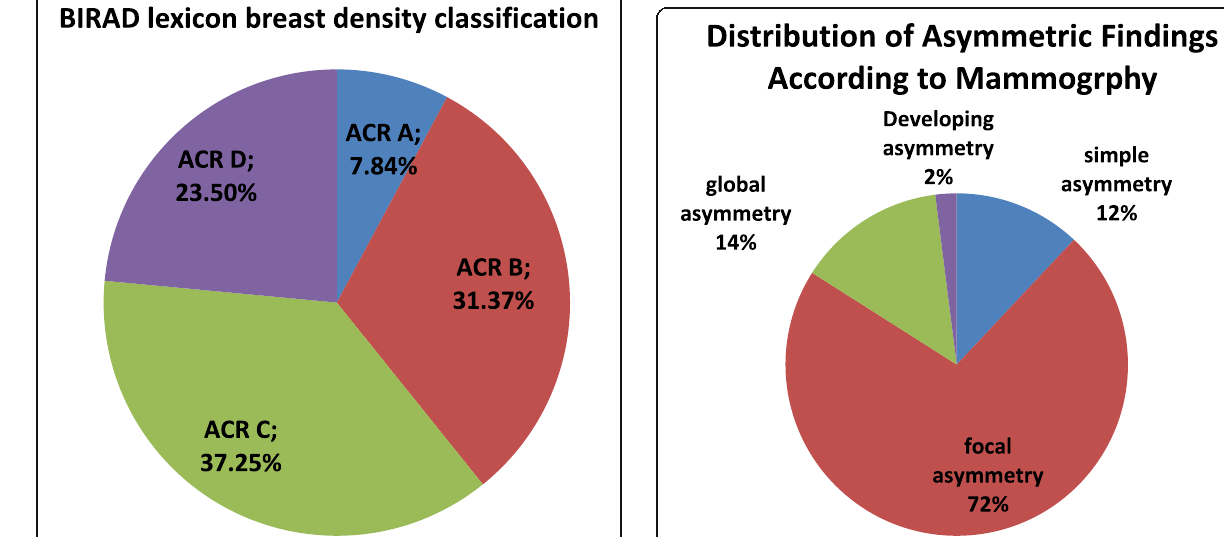
Fig. 2 Distribution of asymmetries according to mammography